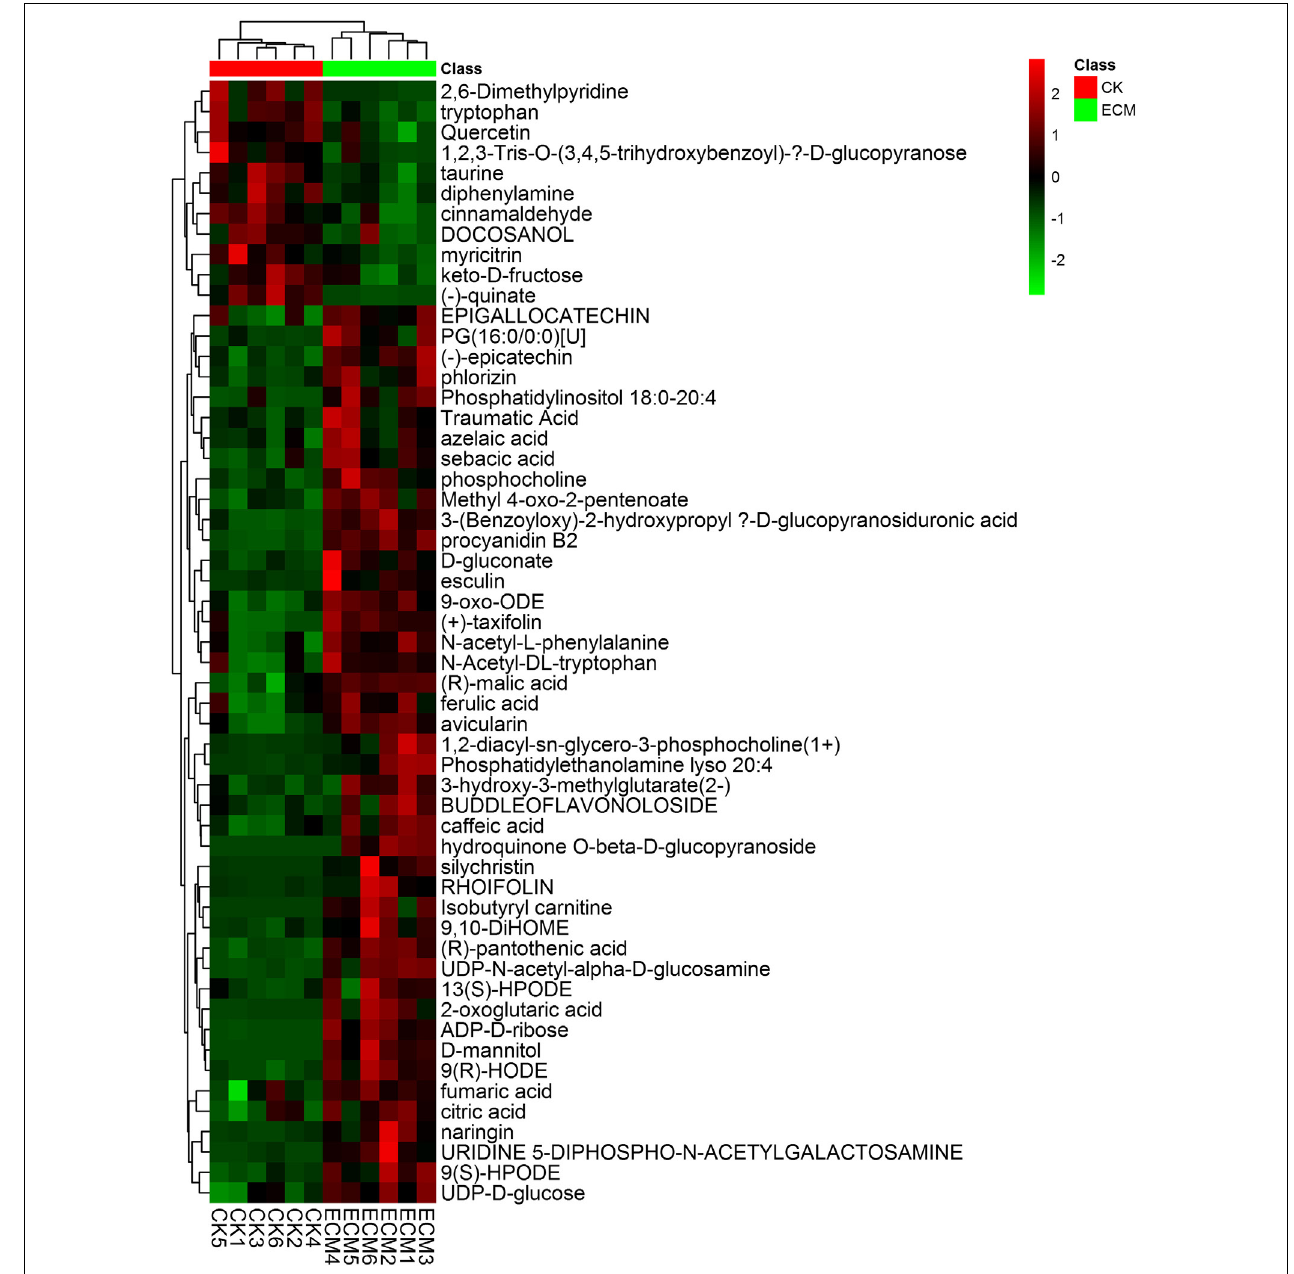
FIGURE 9 | Heat-map analysis of the 55 identified metabolites that differentially expressed between the ectomycorrhizae and the control roots. ECM, ectomycorrhizae ( Q. aliena in association with T. indicum ); CK, roots of Q. aliena without T. indicum partner.